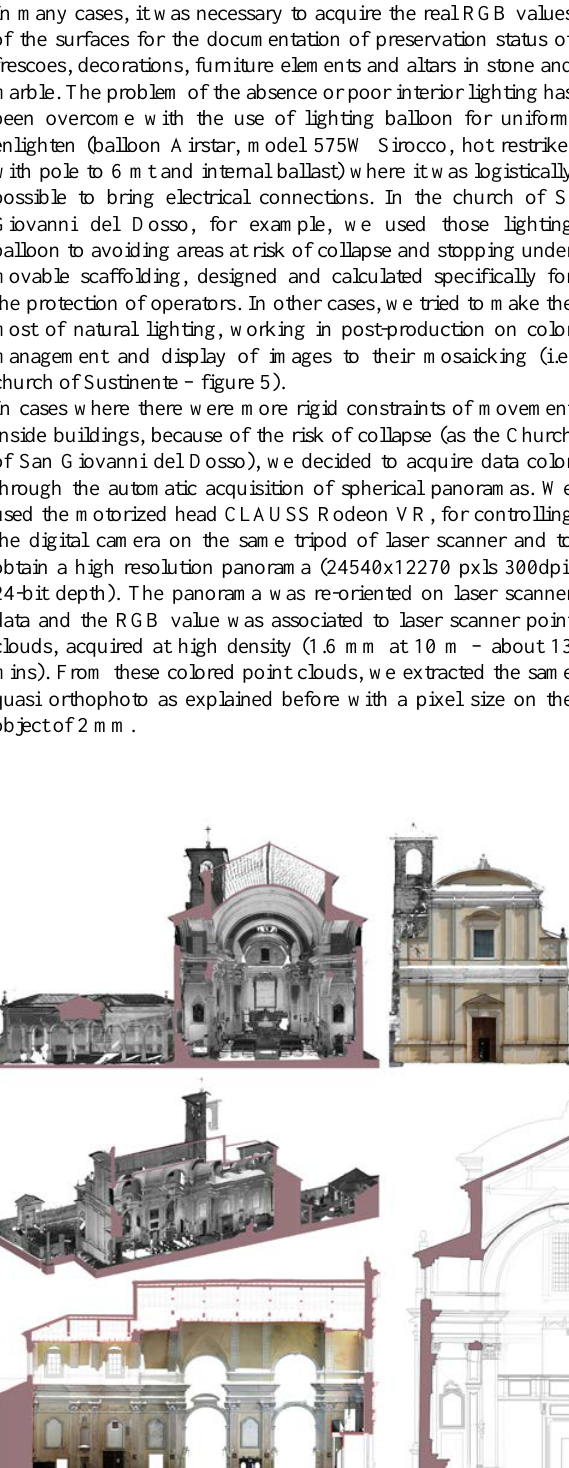
Figure 4. An example of the photogrammetric approach applied for the survey of the lantern of S. Andrea in Mantua. On the left the images oriented and the sparse point cloud, on the right the 3D model